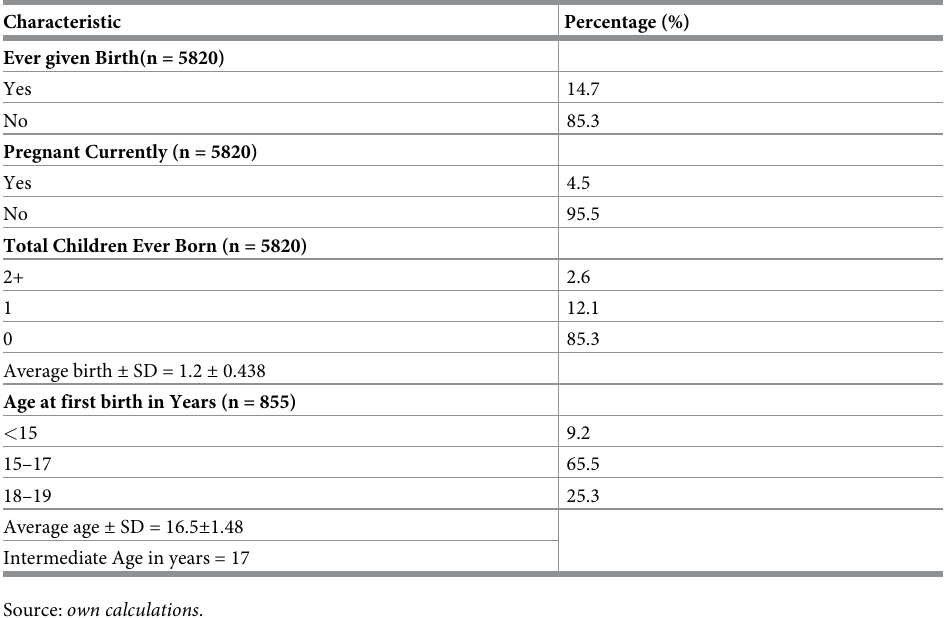
Table 3 illustrates proximate factors associated with adolescent childbearing in Kenya. The observed age-specific fertility rate (ASFR) was 0.17 births per woman. Implying, nearly 2.33 births per adolescent were prevented because of not being married, use of contraception, and postpartum infecundability. Close to 2.34 births per adolescent out of the highest biological number of 2.5 births were avoided among urban teenagers whereas 2.32 births per adolescent residing in rural areas were prevented. Adolescents’ marital index (Cm) was 0.36, implying, not being married decreased adolescent childbearing by 64 percent. The marital indicator was lesser for adolescents that resided in urban areas (0.34) compared to adolescents that resided in rural areas (0.37). Postpartum infecundability was also a significant factor associated with adolescent childbearing; overall it decreased 24% of the biologically maximum expected ado- lescent childbearing level in marriage. Its impact was rather greater among teenage urban Table 2. Adolescent reproductive pattern in Kenya,